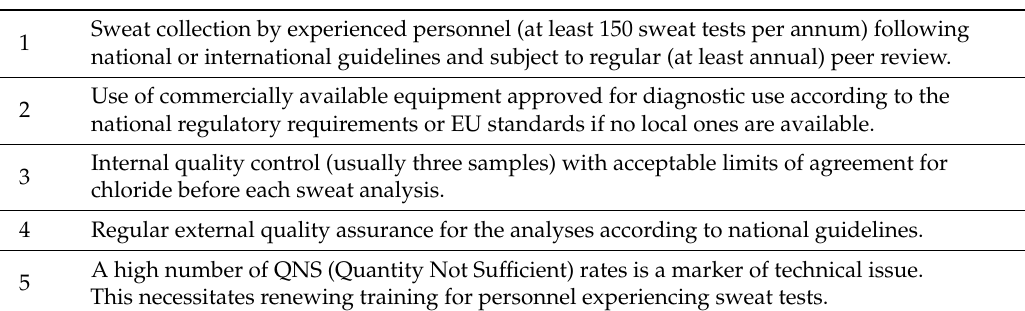
Table 2. Diagnostic standards of a sweat test (according to the ECFS Guidelines, adapted from